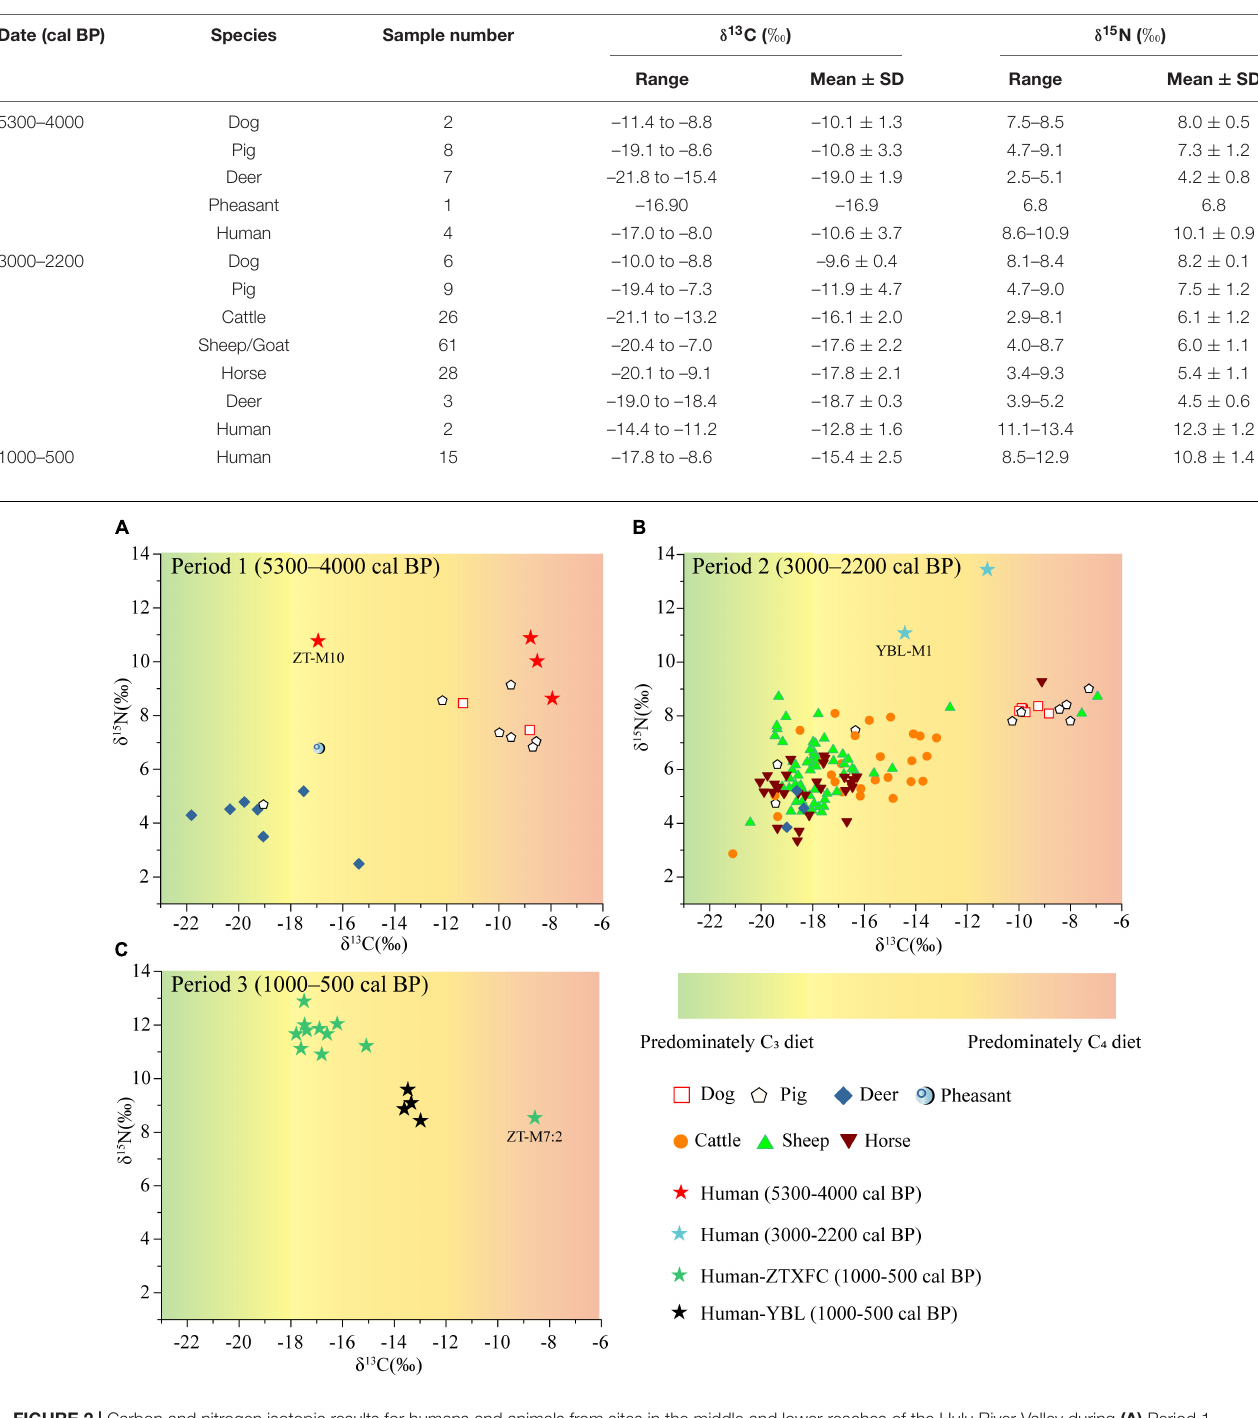
TABLE 2 | Stable isotopic data from three sites in the middle-lower HRV.